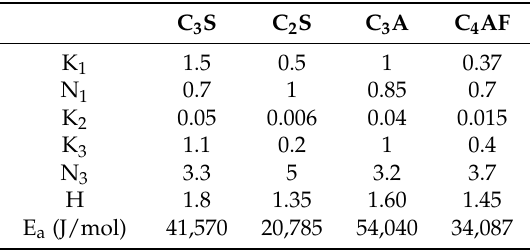
Table A2. Parameters adapted to calculate the hydration degree of the clinker minerals as a function of time